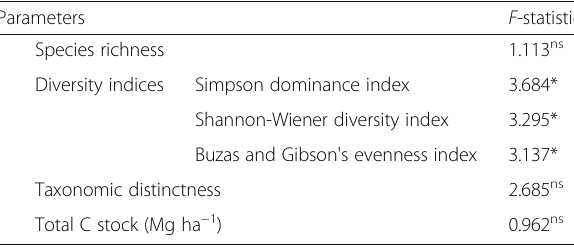
zizanioides as being the most dominant species in all 1: Table S2). However, the dominance and evenness in- the sampling stations (Additional file 1: Tables S3, dices and taxonomic distinctness did not vary signifi- S4). cantly across the flood phases (Additional file 2: Figure S1c – e and Additional file 1: Table S2). The dominance – diversity curve of the wetland vegetation revealed that during the flood phase, most of the resources of wet- land were shared among few dominant species (Add- S2), with Chrysopogon Table 2 One-way analyses of variance showing variations in vegetation attributes in the wetland with sampling stations